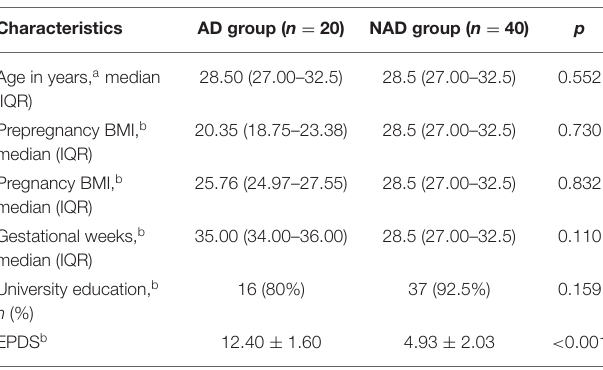
TABLE 1 | Demographic and clinical characteristics of the antenatal depression and non-antenatal depression.